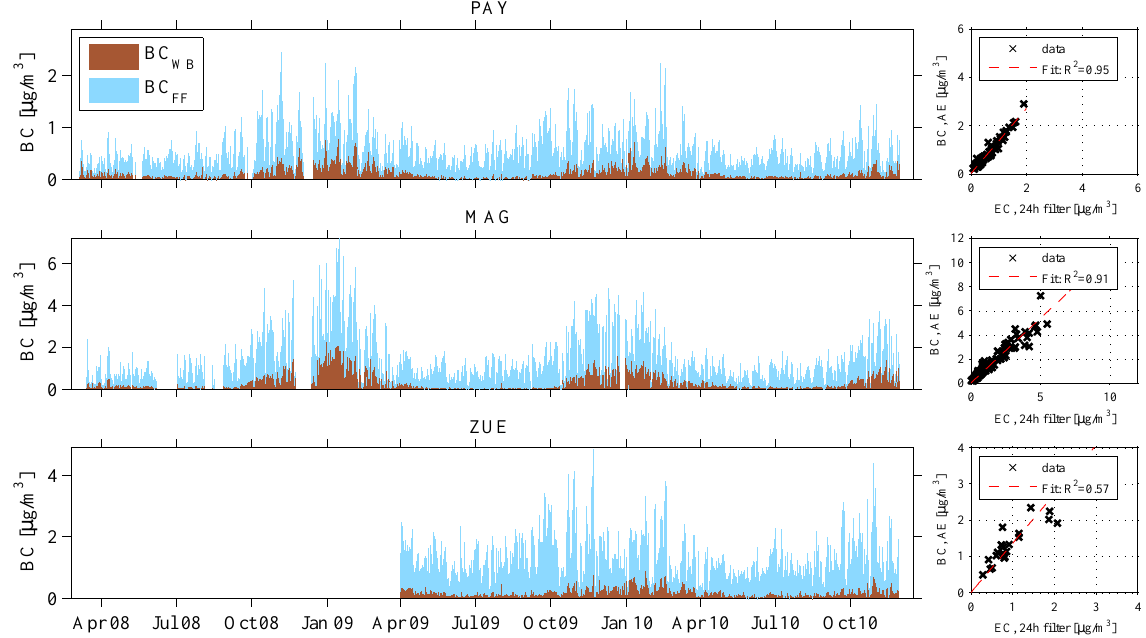
Fig. 3. Long-term pattern of BC FF and BC WB concentrations at PAY, MAG and ZUE (stacked). The scatter plots show the relationship between total daily BC and the daily EC concentration as determined with the thermal optical transmission method at every 4th day from 8 August to 9 July for the corresponding measurement